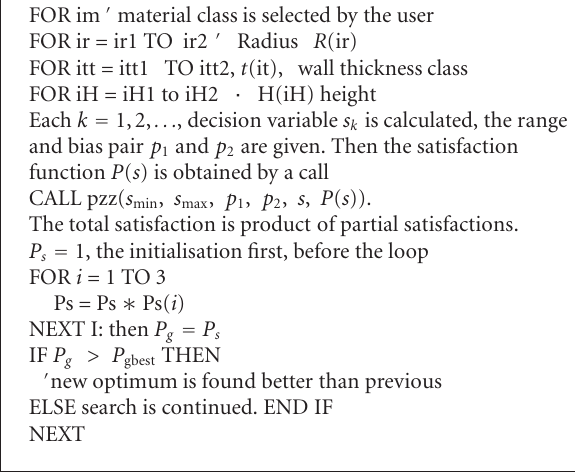
Algorithm 1: Total satisfaction is first initialised to a low value P gbest = . 0000001. Table 4: Total satisfaction for the customer. Pg(im) in products